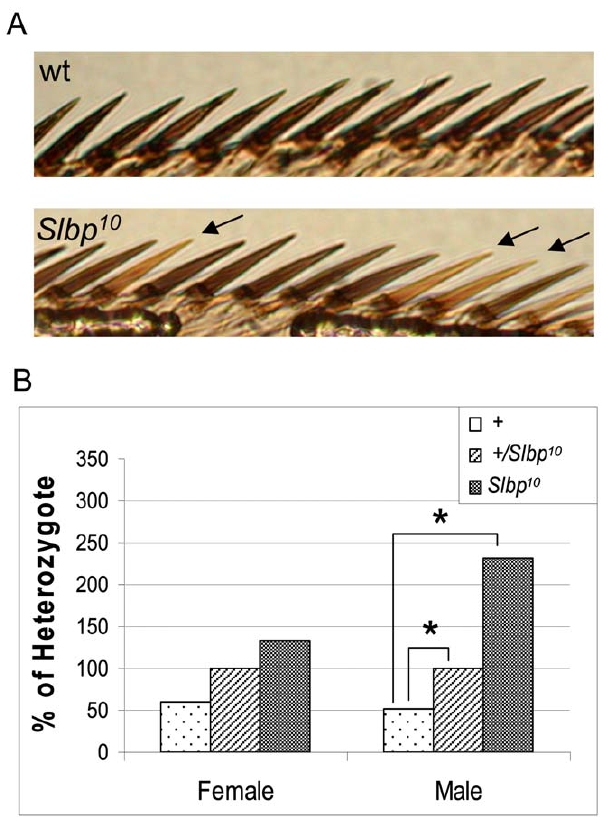
Figure 1. LOH is significantly increased in Slbp mutants. Wings from wt, Slbp 10 mutant flies heterozygous for a fourth chromosome translocation containing y + were mounted and the first twenty bristles of the anterior wing margin were used for analysis. A) Example of the data used for analysis. Yellow bristles indicate an LOH event (black arrows). B) For each Slbp 10 and + class, the frequencies of yellow bristles per wing were compared to heterozygous controls derived from a common culture. Frequency of yellow bristles was tabulated on a per wing basis. Data are expressed as a percentage of heterozygous controls, so that genotypes can be compared across experiments. 21-45 wings were analyzed per class. P-values are indicated as follows: * p , 0.05, **p , 0.01, ***p ,